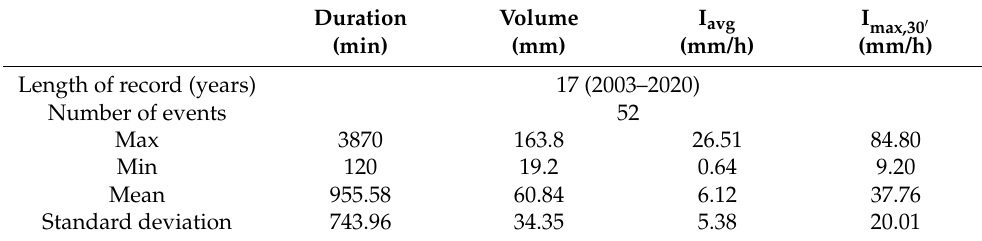
Table 2. Main characteristics of the selected maximum rainfall events.